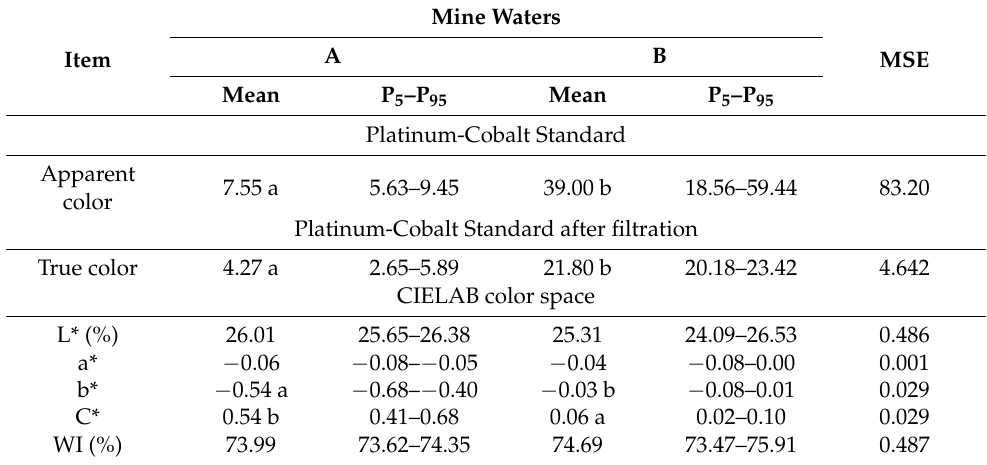
Table 2. Assessment of the color of mine